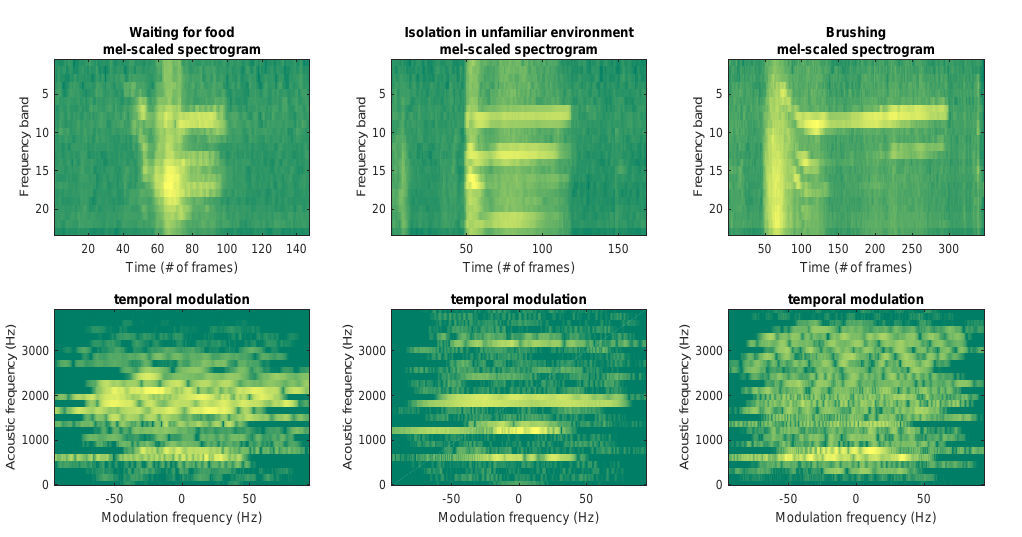
Figure 4. Representative representations of Mel-scaled spectrogram and temporal modulation corresponding to all three classes ( waiting for food , isolation in unfamiliar environment , and brushing